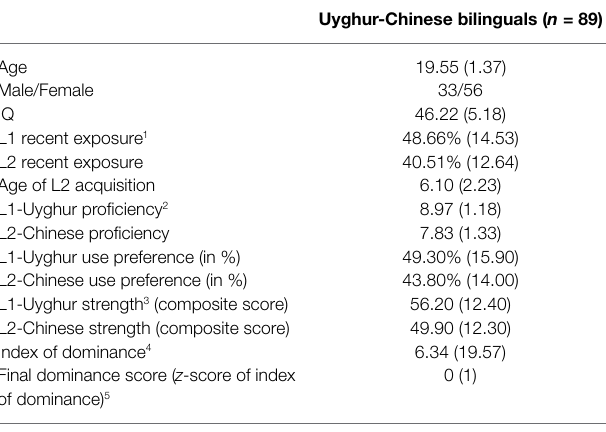
TABLE 1 | Mean scores and standard deviations (in parenthesis) for language experience background information of bilingual participants.